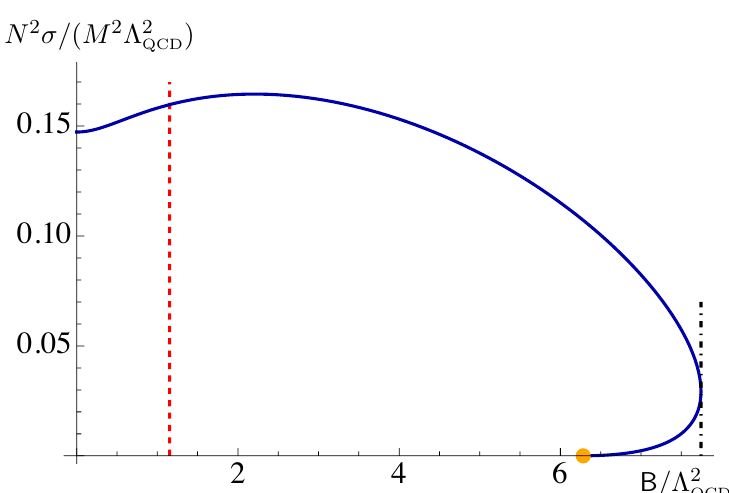
Figure 6. String tension in units of the confinement scale, computed from the quark/antiquark potential, as a function of the magnetic field. The red dashed line indicates the magnetic field at which the confining backgrounds cease to be dominant. The black, dot-dashed line corresponds to B while the orange dot labels B max sat